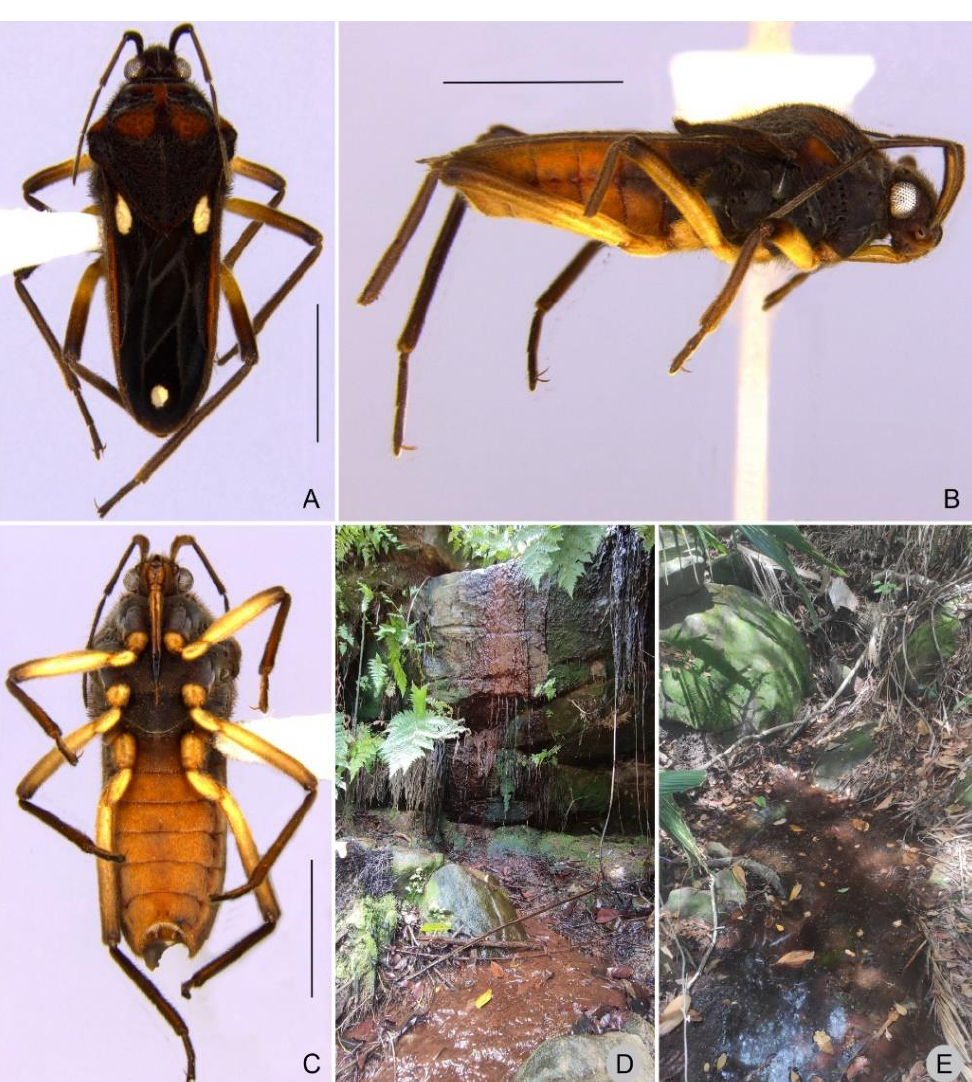
Figure 8. Paravelia digitata from Piauí state. ( A – C ). Habitus. ( A ). Macropterous female, dorsal view. ( B , C ). Macropterous male. ( B ). Lateral view. ( C ). Ventral view. ( D , E ). Photographs of the stream where the species was collected in Catimbau National Park (08°33 ′ 27.6 ” S, 37°11 ′ 42.2 ” W; 15.III.2021). Scale bars: 2.0 mm.